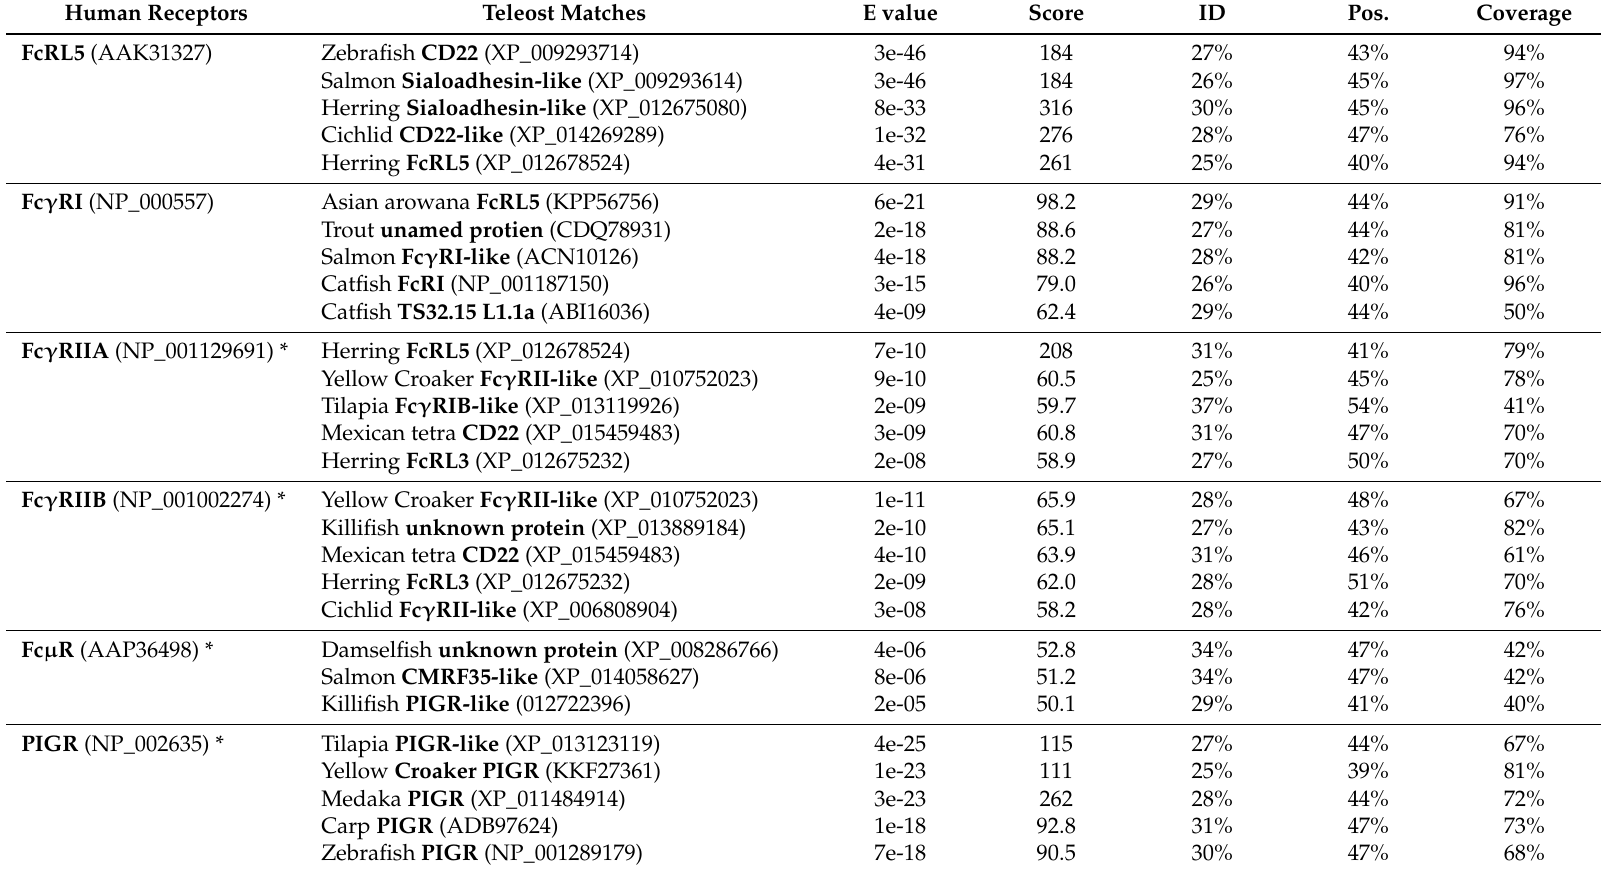
Table 2. Protein BLAST searches for human immunoregulatory receptor-like sequences in teleost fishes. Human